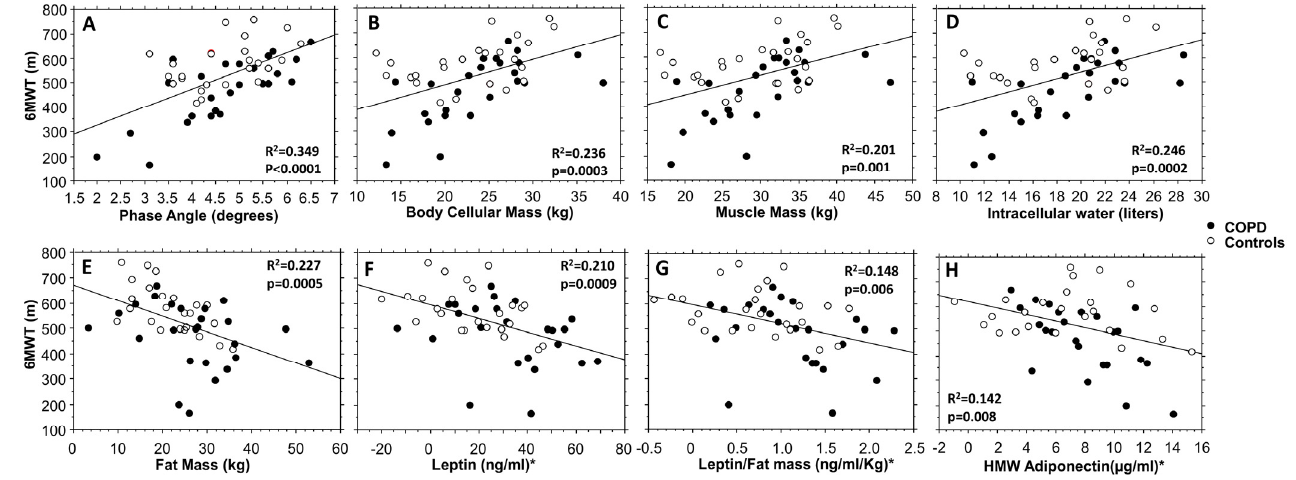
Figure 4. For both COPD and control groups, linear positive correlations between 6MWT and phase angle ( A ), body cellular mass ( B ), muscle mass ( C ), and intracellular water ( D ), linear inverse correlations between 6MWT and fat mass ( E ), leptin ( F ), leptin/fat mass ratio ( G ), HMW adiponectin ( H ).* Leptin, leptin/fat mass ratio, and HMW adiponectin values were normalized by mean and standard deviation.